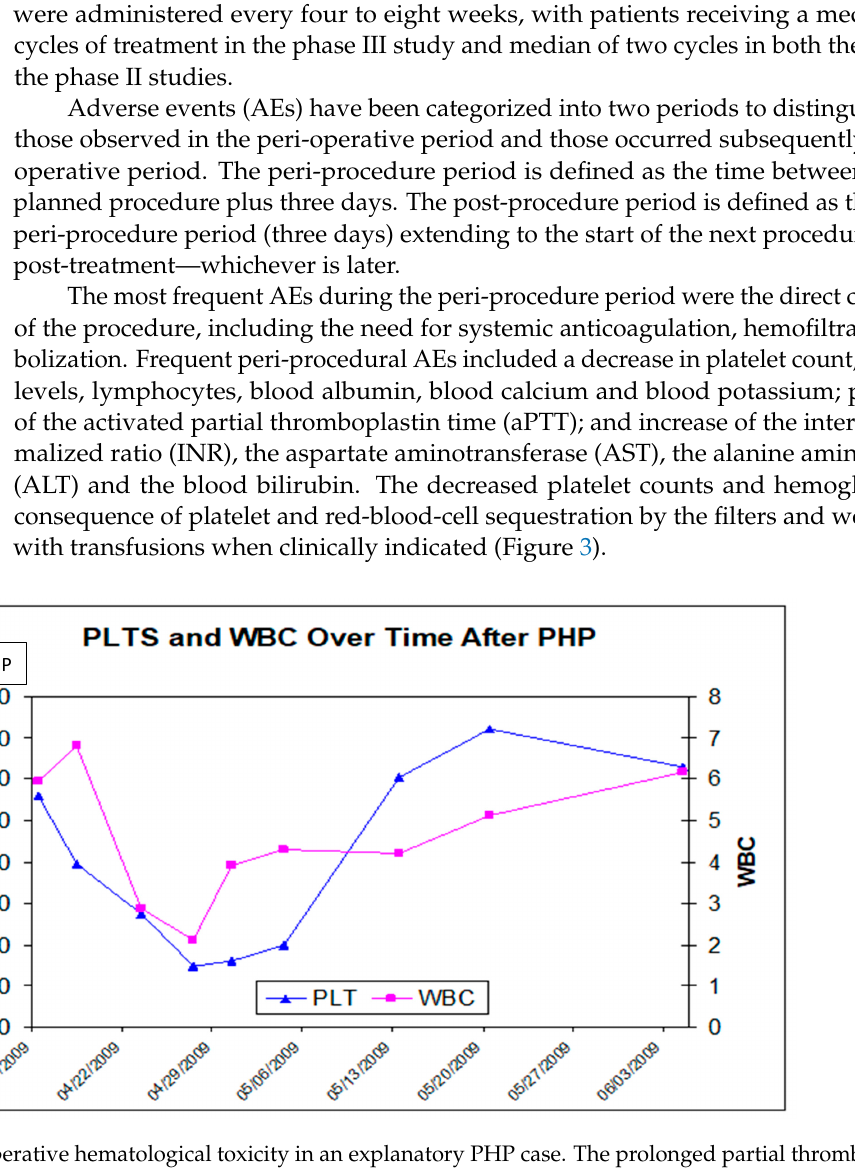
Table 3. Grade 3/4 and Grade 5 treatment related hematological and hepatic toxicity as experi- enced by a selection of 55 patients who performed 160 treatments within clinical trials or following standard indication. Hematological Toxicity on 160 PHPs